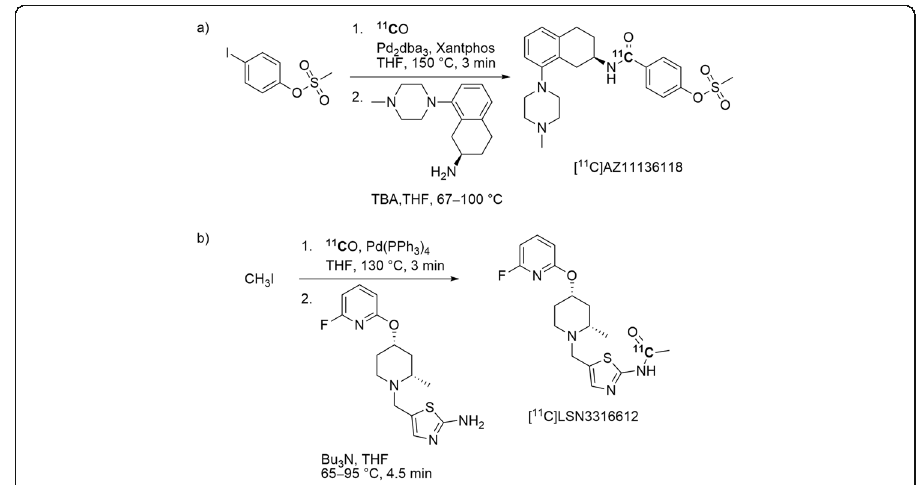
Fig. 26 11 C-Labeling of a [ 11 C]AZ11136118 and b [ 11 C]LSN3316612 with [ 11 C]carbon monoxide